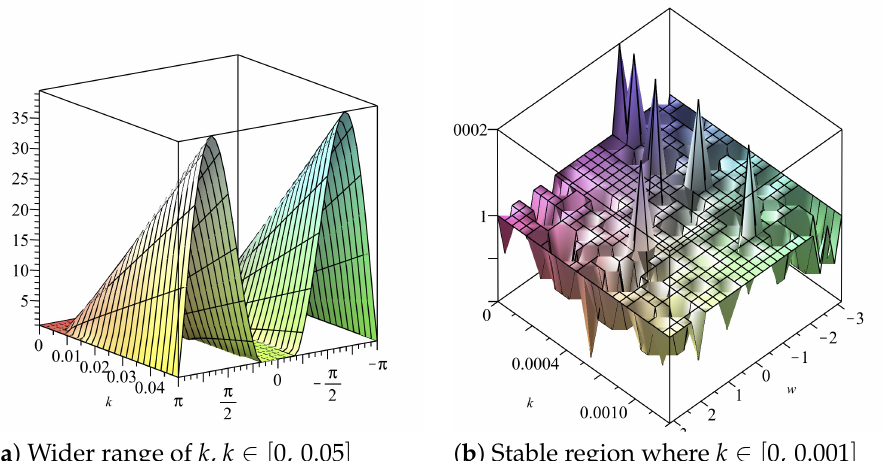
( a ) Wider range of k , k ∈ [ 0, 0.05 ] ( b ) Stable region where k ∈ [ 0, 0.001 ] Figure 27. Plot of | ξ 2 | vs. k vs. w ∈ [ − π , π ] of Scheme 3 for Numerical Experiment 2. The spatial step size h = π